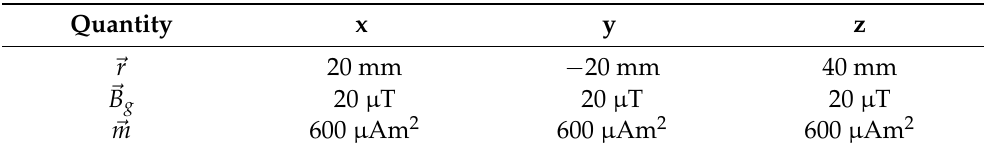
Table 1. Default values used as starting guesses (unless differently specified) for the target position (cid:126) r , the environmental field (cid:126) B g , and the magnetic dipole (cid:126) m